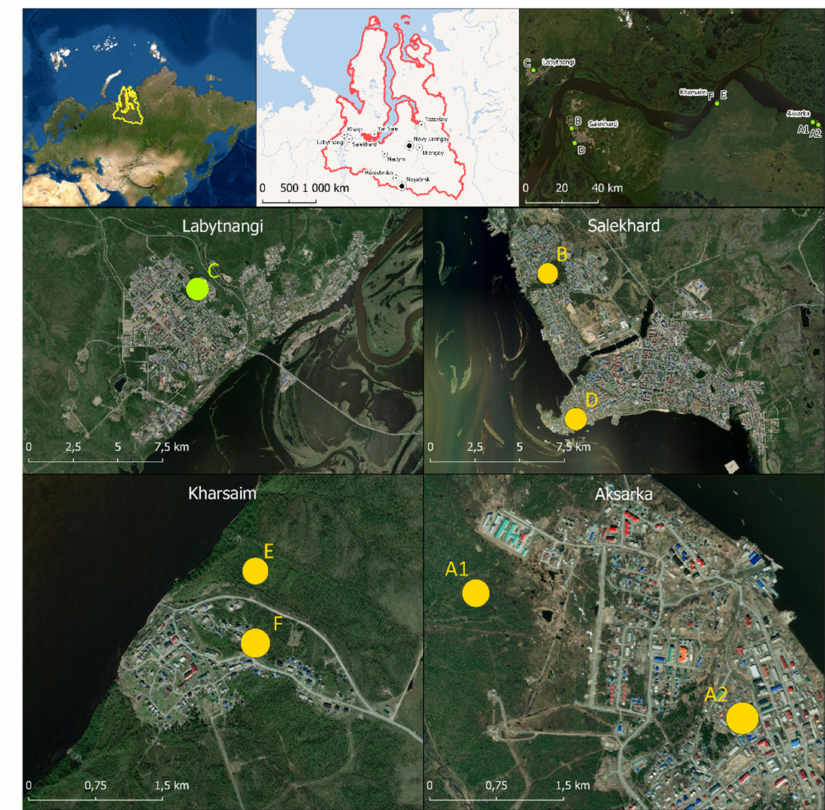
Figure 1. Sampling map of the study area: ( A1 , E , F )—mature soils; ( A2,B,C,D )—anthropogenic loaded